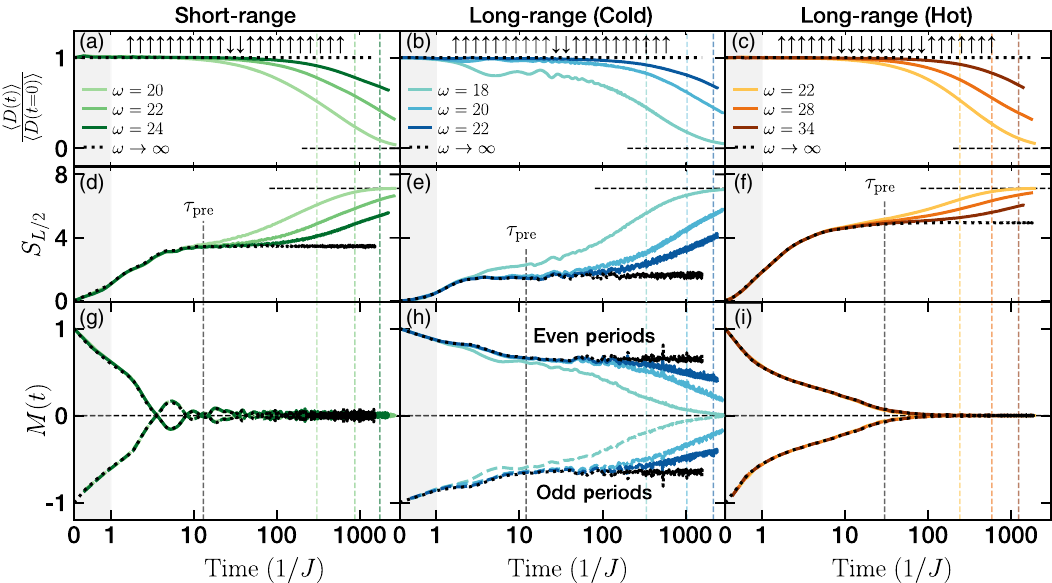
FIG. 3. Evolution of an L ¼ 22 spin chain under the short-range model (left-hand column) and the long-range model. For the latter, we consider a “ cold ” initial state near the top of the spectrum of D (cid:2) (center column) and another “ hot ” state near the center of the spectrum (right-hand column). (a) – (c) Evolution of the energy density h D i =L . Regardless of the model or initial state, the heating timescale τ (cid:2) (which measures the approach to infinite temperature) scales exponentially in the frequency of the drive. (d) – (f) Evolution of the entanglement entropy S L= 2 . At intermediate times and large frequencies we observe a plateau corresponding to the entanglement entropy of the prethermal state, as independently corroborated by the evolution under the ω → ∞ limit of our Floquet evolution (captured on even periods by the evolution under D ). Analogous to the energy density, at late times ( t > τ (cid:2) ), the entanglement entropy approaches its infinite temperature value of ½ L log ð 2 Þ − 1 (cid:3) = 2 [94]. (g) – (i) Evolution of M ð t Þ for even (full line) and odd periods (dashed line). In both the short-range model (g) and the “ hot ” long-range initial state (i), any period doubling behavior of the magnetization quickly decays as the system approaches, independently of frequency, the prethermal state at τ . By contrast, in the “ cold ” long-range initial state (h), the pre magnetization exhibits a robust period doubling behavior for as long as the energy density remains conserved; the decay of both quantities occurs at τ (cid:2) ¼ O ð e ω =J local Þ and the prethermal time crystal is robust. This distinction is even clearer when considering the ω → ∞ limit of our Floquet evolution, where the magnetization shows no signs of